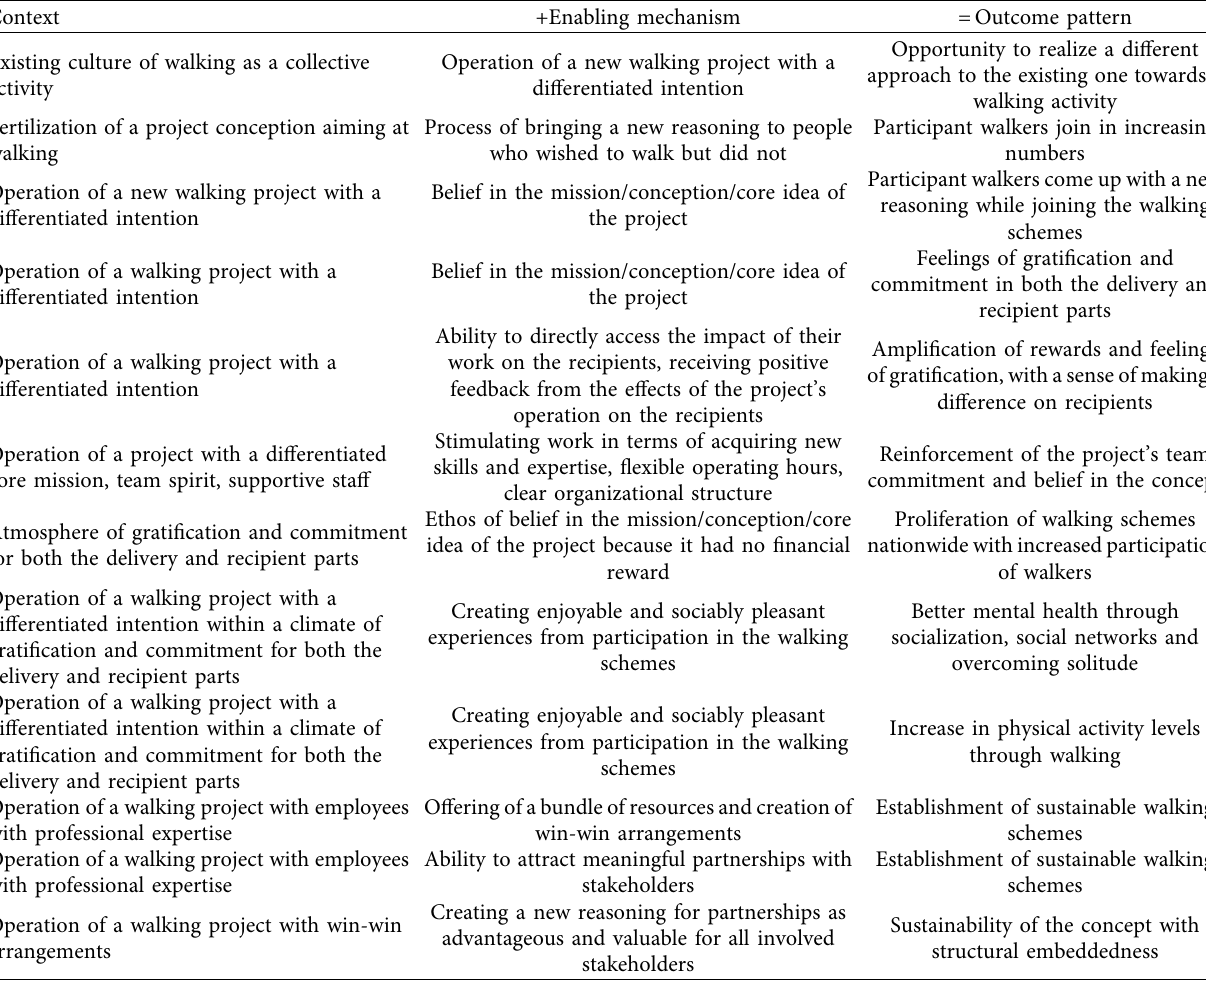
Table 4: Summary of CMO configurations in the Walking for Health (WfH)